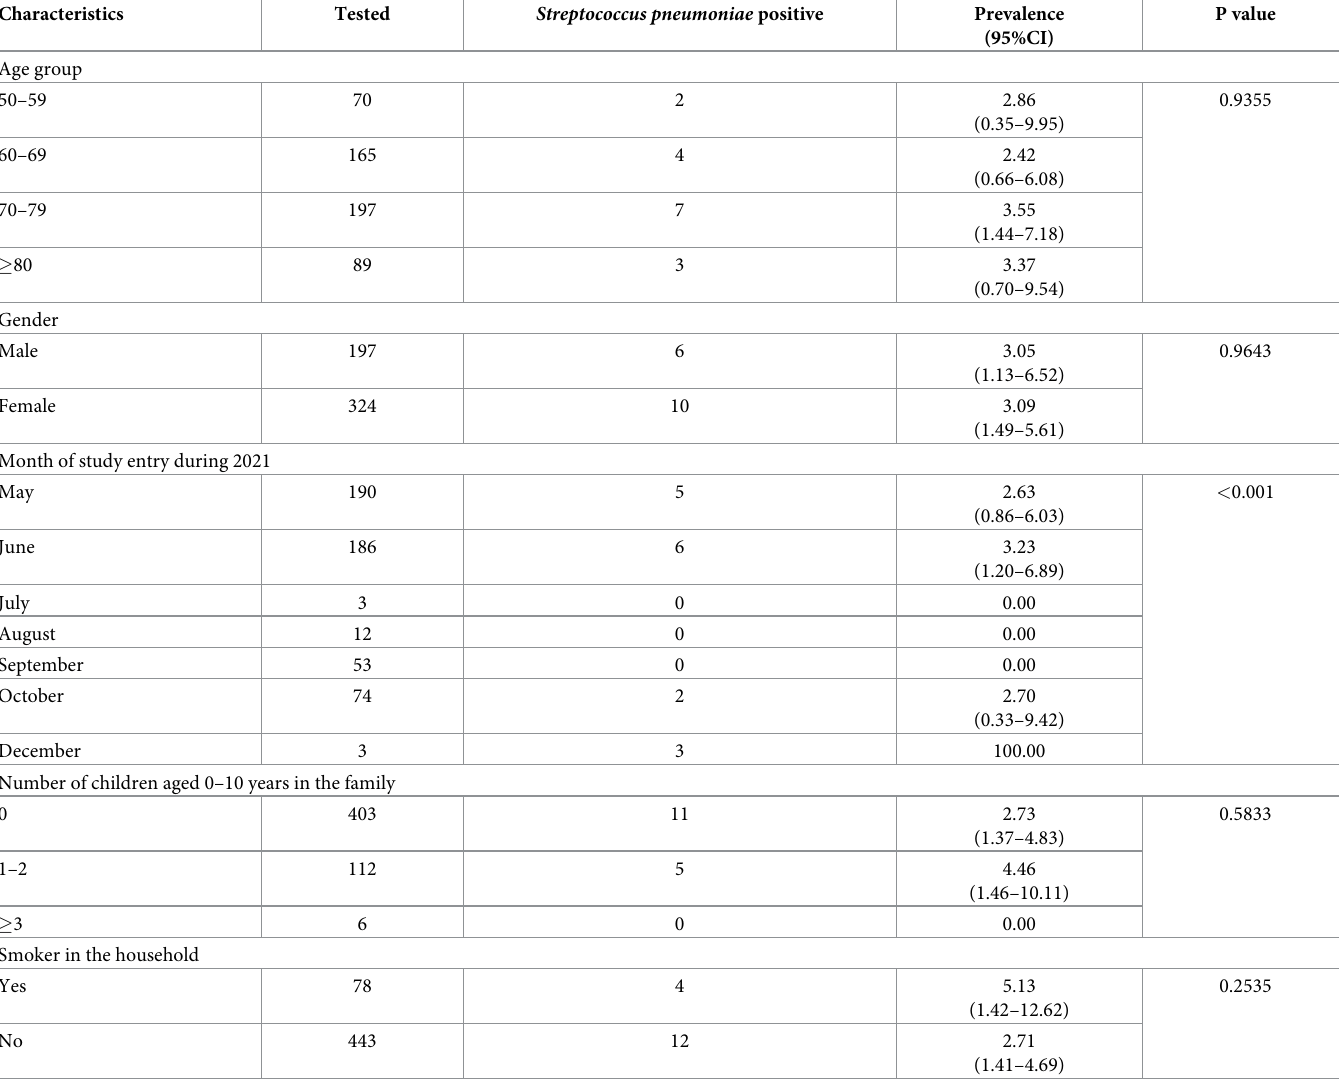
Table 2. Associations between characteristics of participants and carriage of Streptococcus pneumoniae